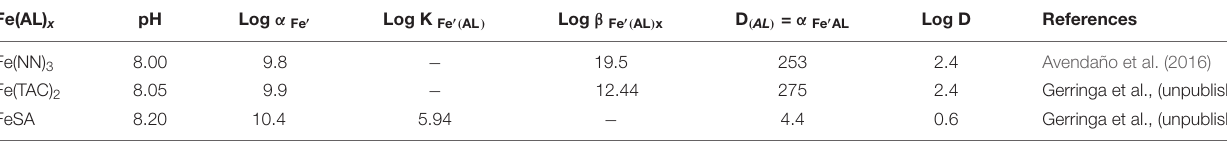
TABLE 1 | Summary of the formed Fe(AL) x complexes and the detection window of each voltammetric